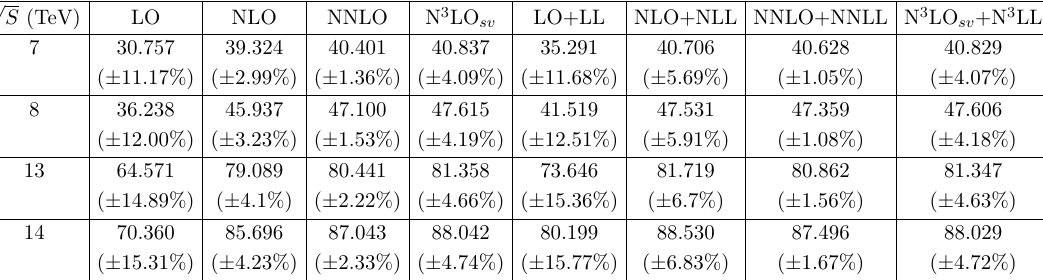
Table 3 . Same as table 1 but for W (cid:0) production at the